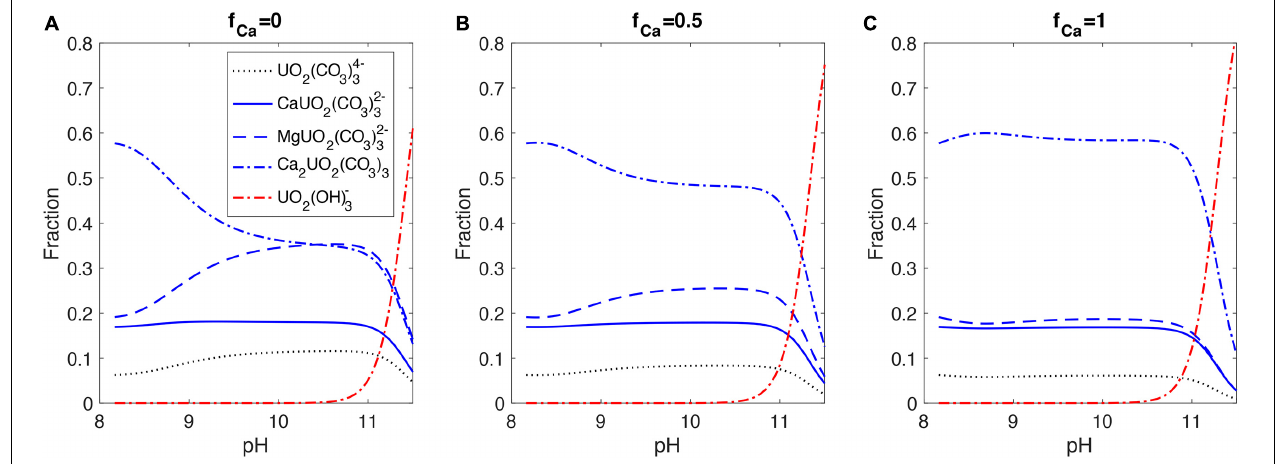
FIGURE 6 | Uranium speciation with pH in the ECF from the coral biomineralization model. The three panels correspond to different fractions of Ca 2 + ( f Ca ) in the alkalinity pump ( [A] f Ca = 0, [B] f Ca = 0.5, [C] f Ca = 1). Uranium speciation is calculated with steady state [Ca 2 + ], [Mg 2 + ], and carbonate chemistry simulated by the model corresponding to prescribed alkalinity pump rates. [Mg 2 + ] is almost constant in the model due to very limited removal by precipitation (D Mg < < 1 in